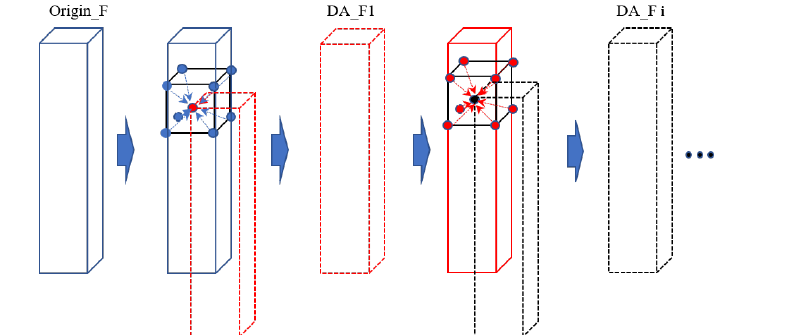
Figure 4. New pixels produced by the dual adjacent